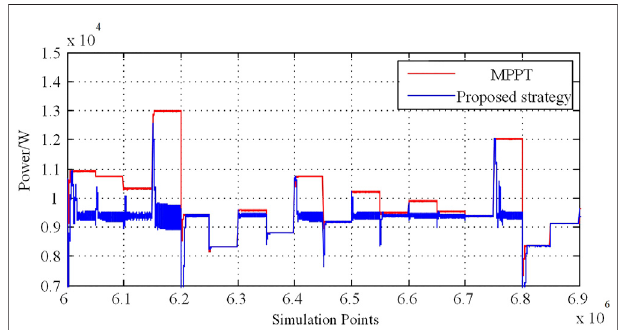
FIGURE 1 | Simulation results based on maximum power point tracking (MPPT) control strategy and the proposed control strategy.